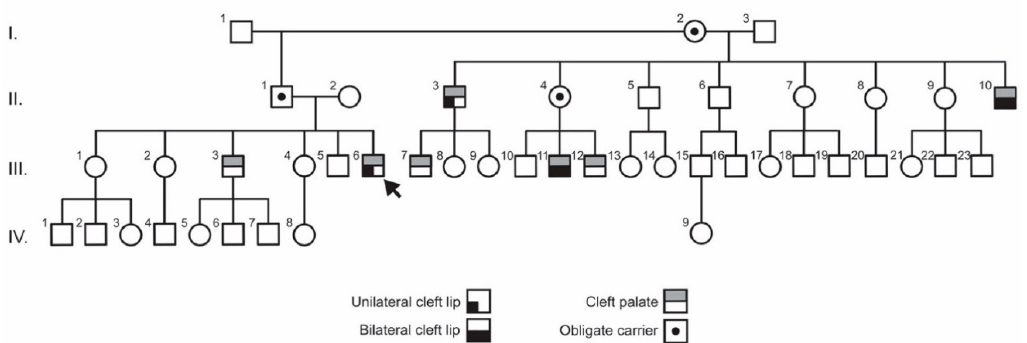
Figure 1. Pedigree of Honduran family with non-syndromic cleft lip and/or palate (NS-CL/P). Pedigree shows inheritance from individual I-2 through both sides of the pedigree: II-1, III-3, III-6 & II-3, III-7, II-4, III-11, III-12, and II-10. Arrow marks the proband (individual III-6).